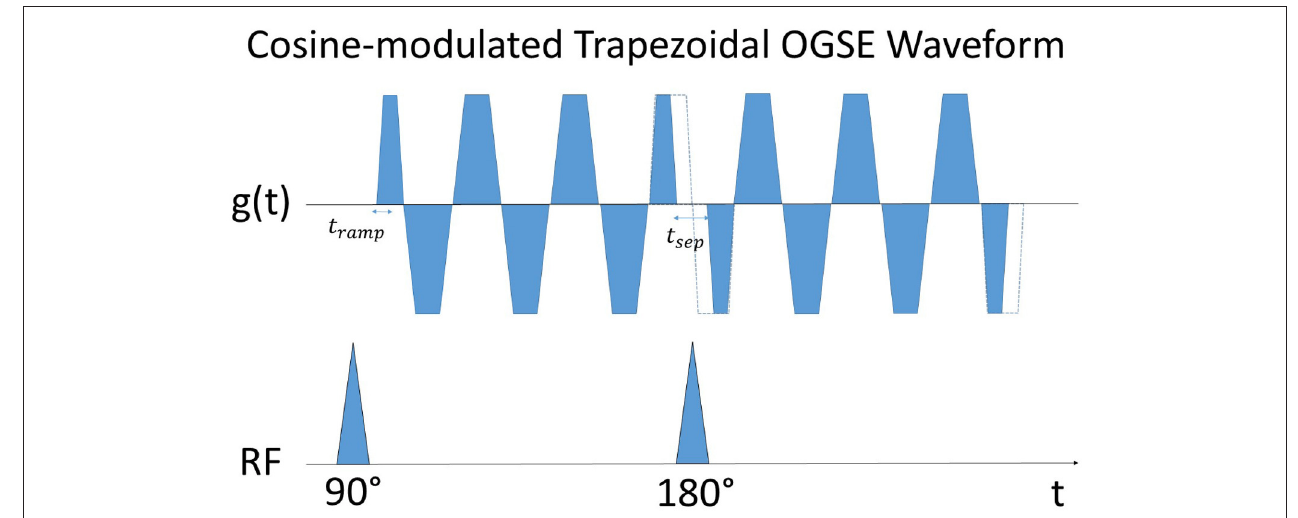
FIGURE 4 | Schematic representation of the employed trapezoidal cosine OGSE gradient waveform, here with six lobes (half-periods) before and after the 180 ◦ refocusing pulse. The separation between gradient waveforms, t sep , is required to accomodate the 180 ◦ RF pulse, and has been set to allow a continuous single frequency oscillating gradient to be drawn between the two waveforms to obtain a narrower peak at the desired frequency [28]. The duration of the shorter lobes are increased by half the gradient ramp time, t ramp , to ensure zero cumulative gradient area.